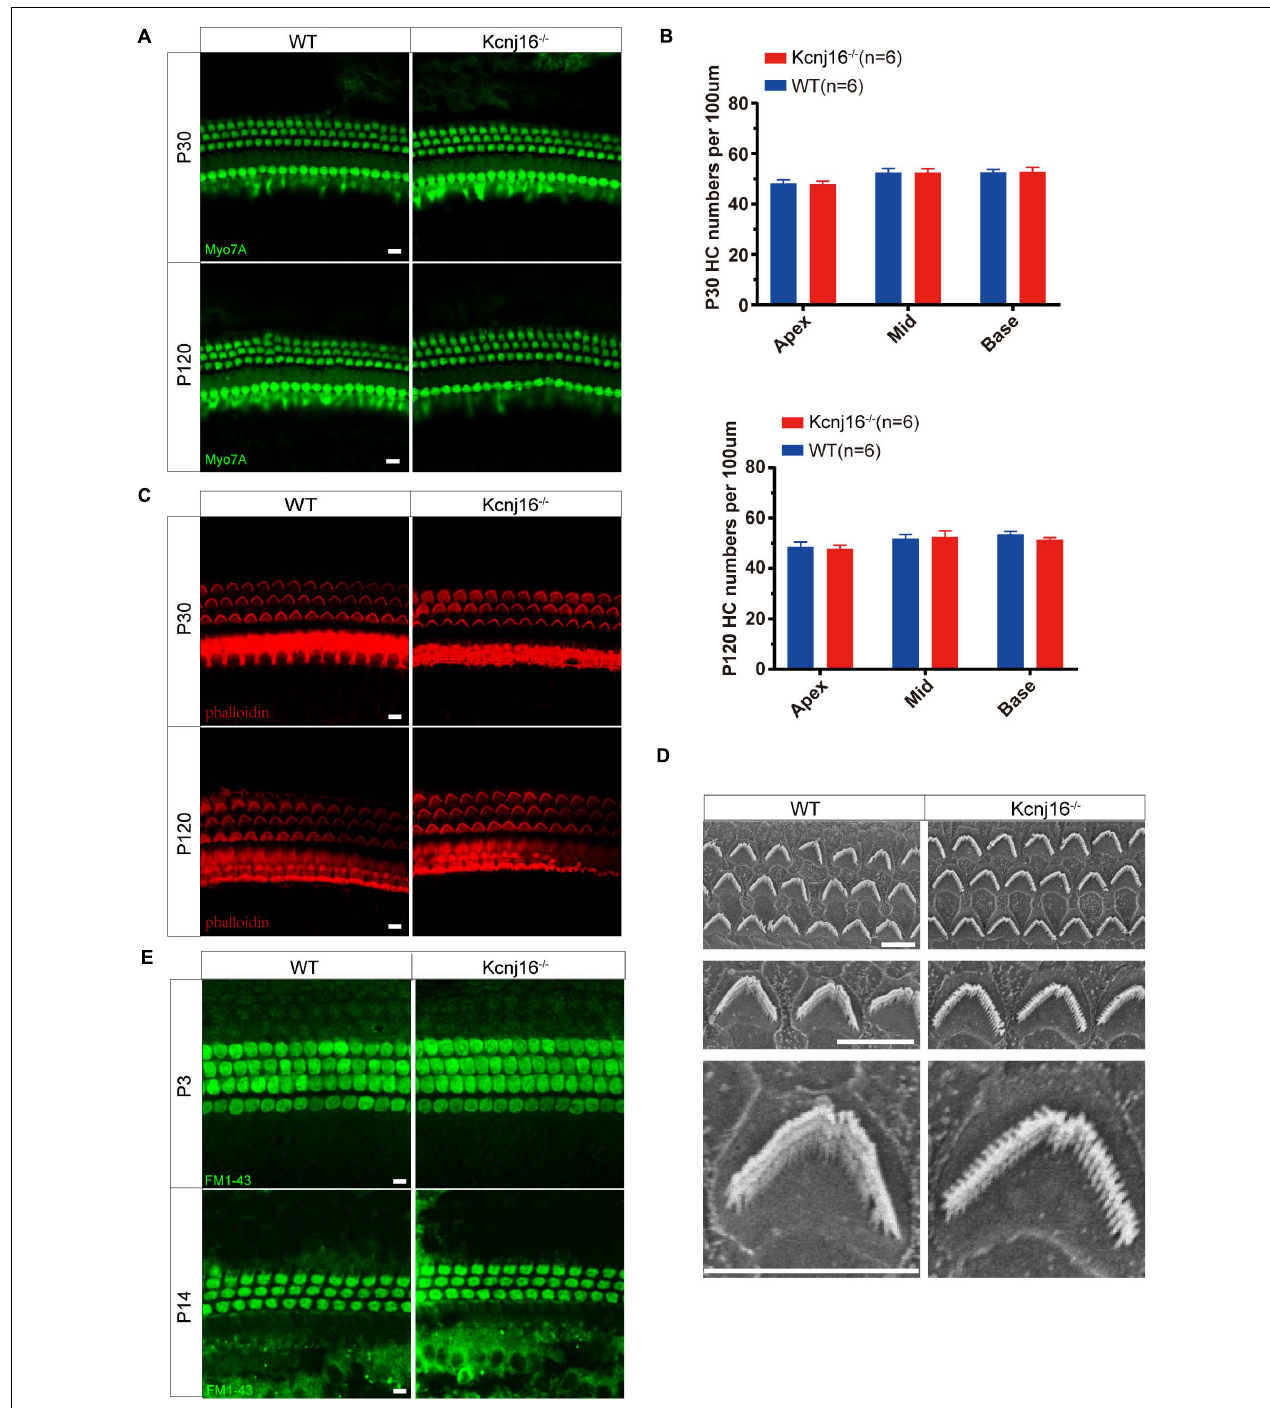
FIGURE 4 | Cochlear development and stereocilia structures were normal in the Kcnj16 − / − mice. (A) Auditory HCs of P30 and P120 mice were stained with antibodies against Myo7A and imaged using a confocal microscope. Images were taken from the basal turn of the cochlea. There was no difference in the staining from the apical to basal turns. Scale bar = 10 µ m. (B) The HCs were counted and compared with age-matched WT mice ( p > 0.05, n = 6). Data are presented as the mean ± SD. (C) Auditory HC stereocilia of Kcnj16 − / − and WT mice were stained with phalloidin, and images were taken from the basal turn of the cochlea. There was no difference from the apical to basal turns. Scale bar = 10 µ m. (D) Low magnification and high magnification scanning electron microscope images of OHC stereocilia bundles in Kcnj16 − / − and WT mice. Images were taken from the middle turn of P60 mice. Scale bar = 5 µ m. (E) Auditory HCs of P3 and P14 mice were stained with FM1-43, and images were taken from the basal turns. There was no difference in the immunolabeling signals from the apical to basal turns (data not shown). Scale bar = 10 µ m.